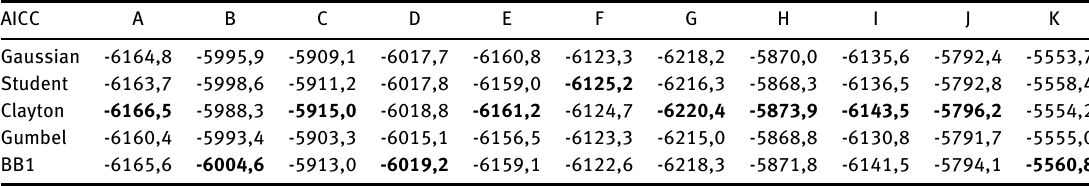
Table 4: AICC values for the models with constant copula parameter AICC A B C D E F G H I J